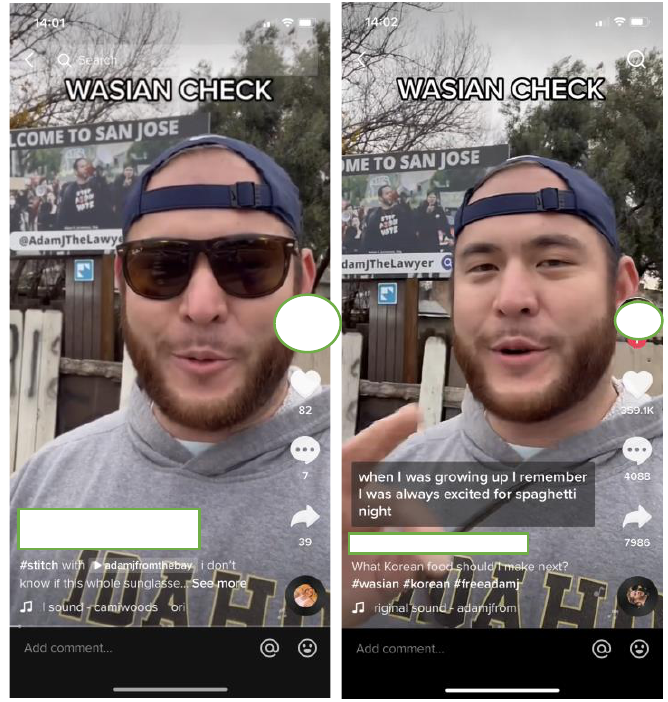
Figure 3. The Sunglasses